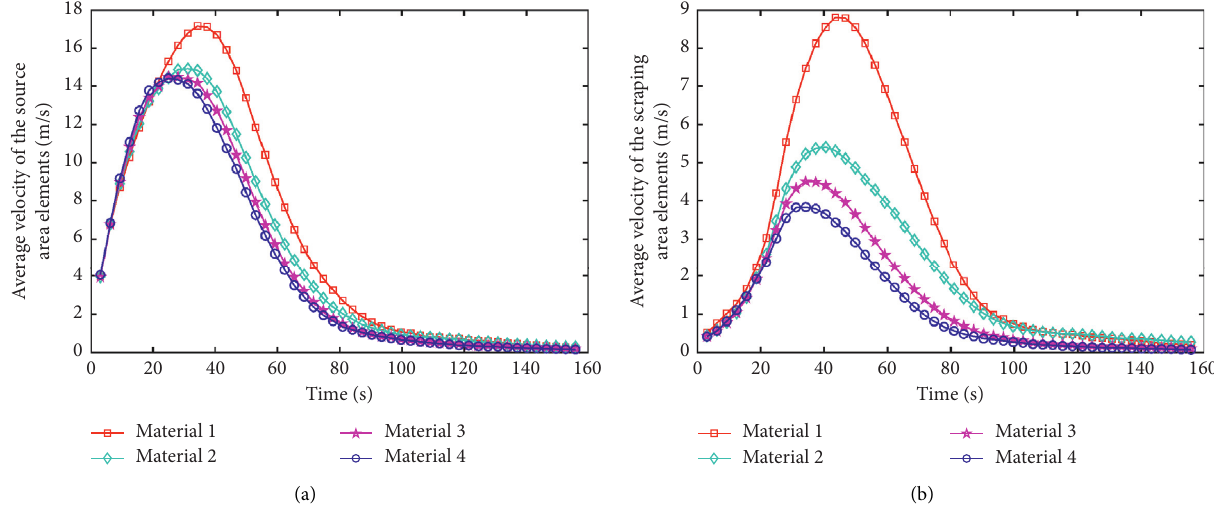
Figure 14: The average velocity of the (a) source area and (b) scraping area elements of four materials with different strength.